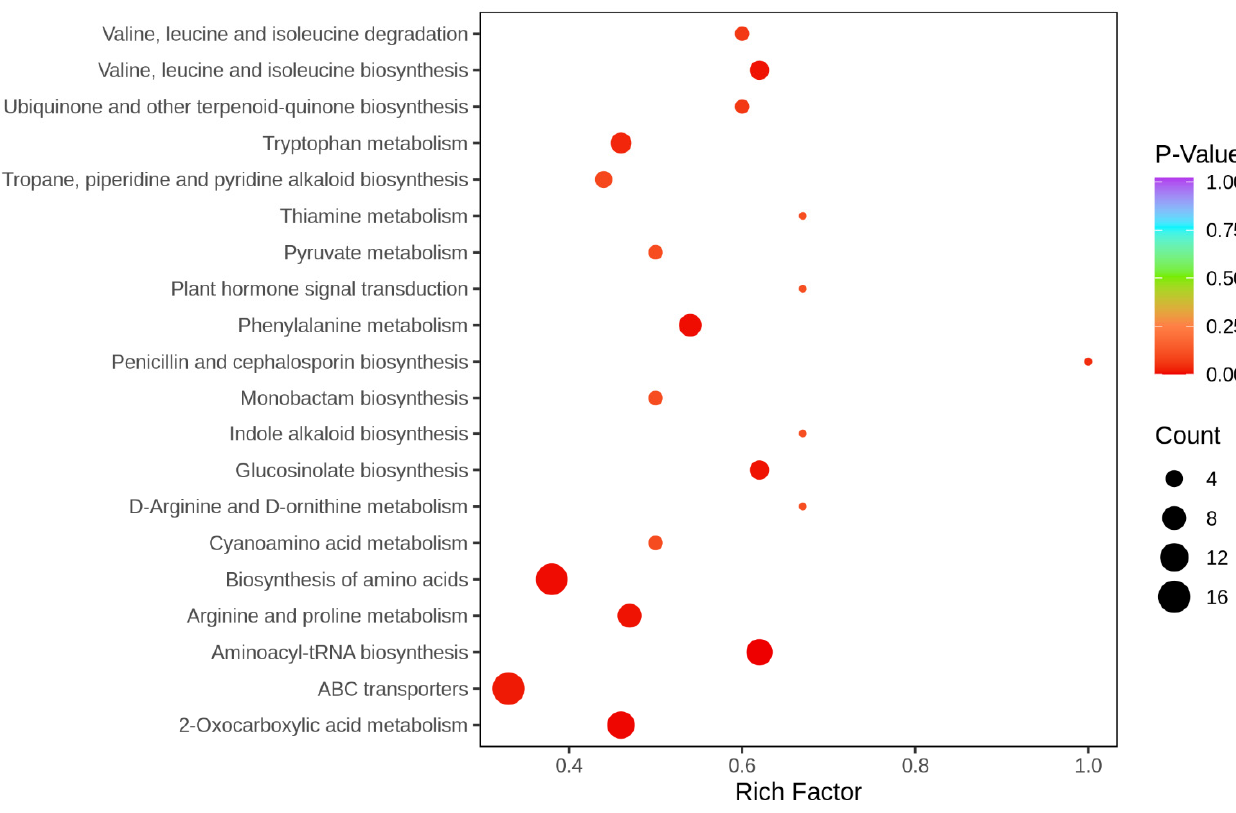
Figure 6. Classification of significantly regulated metabolites (SRMs).